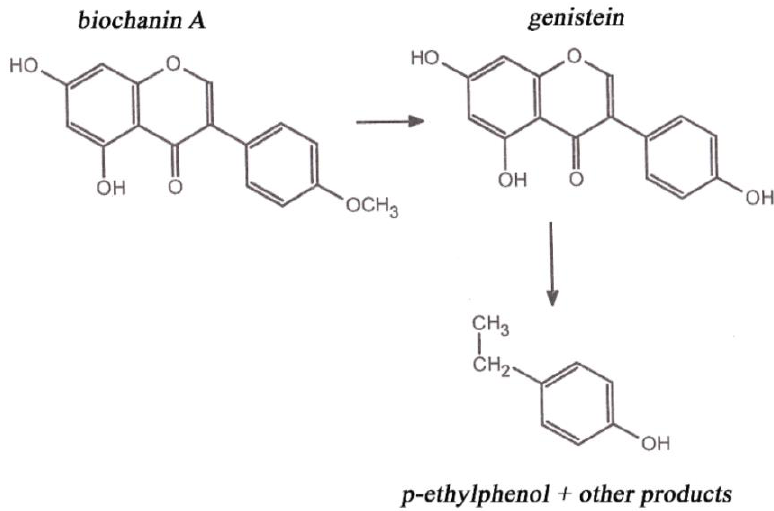
Figure 2. Biochanin A metabolism in sheep.